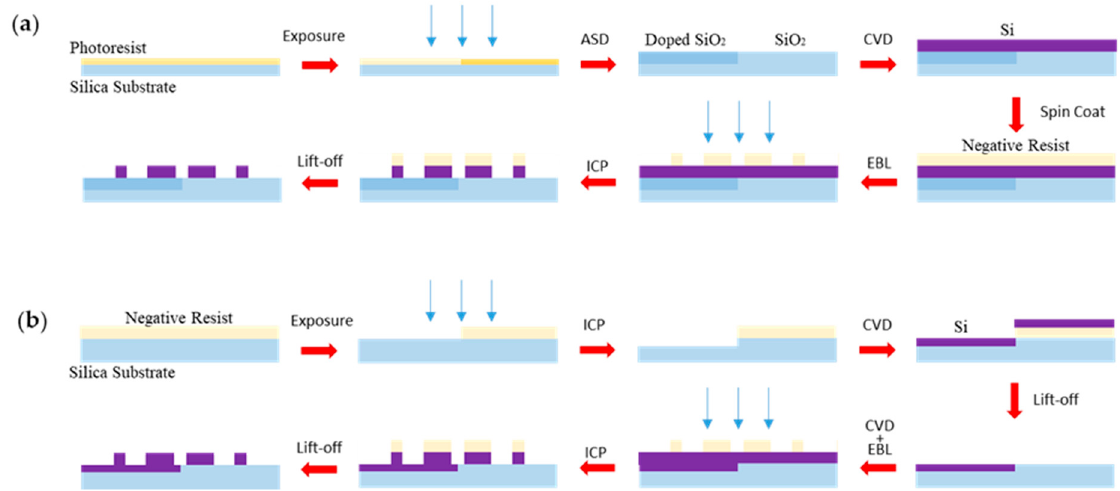
Figure 7. The assumed fabrication process of arbitrary splitting ratios beam splitter. ( a ) Changing refractive index of the substrate. ( b ) Adding the Si film to the substrate.